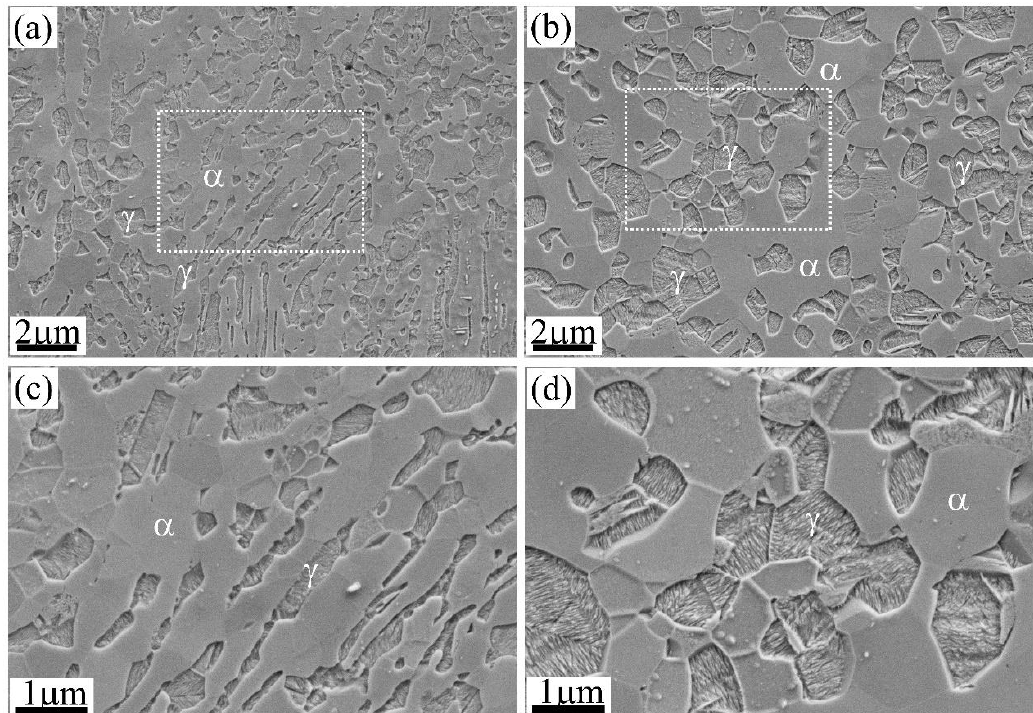
Figure 4. The scanning electron microscope (SEM) images of medium Mn steel with different morphology of austenite resulted from the varied annealing states, including the ( a , c ) continuous annealing and ( b , d ) batch annealing. γ : austenite; α : ferrite. ( c , d ) The enlarged view of dashed rectangles in ( a , b ), respectively.